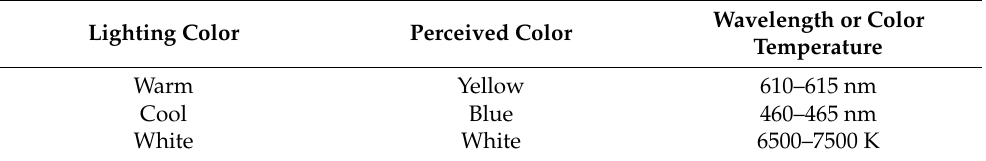
Table 2. Values of lighting colors.